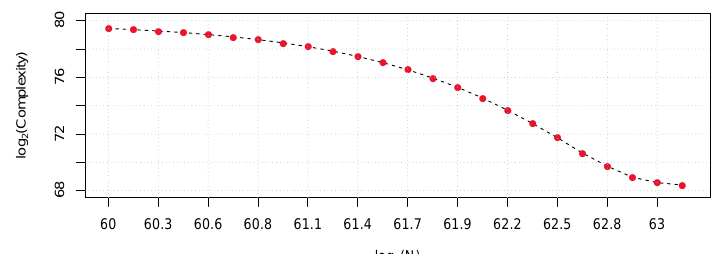
Figure 5: Our 26 round attack: Computational complexity as a function of data complexity for the 26-round attack on present using 135 approximations over 22 rounds. Non-distinct random texts were used, and P S = 0 . 95. Note that the complexity reaches a lower limit close to N = 2 63 when the advantage becomes sufficiently large.